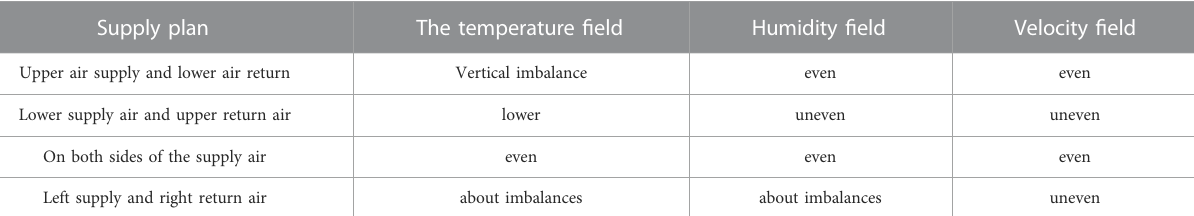
TABLE 4 Load distribution table of each envelope at